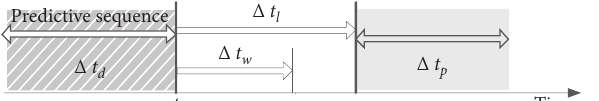
t t l : lead time; Δ w : warning time; Δ p : prediction period;